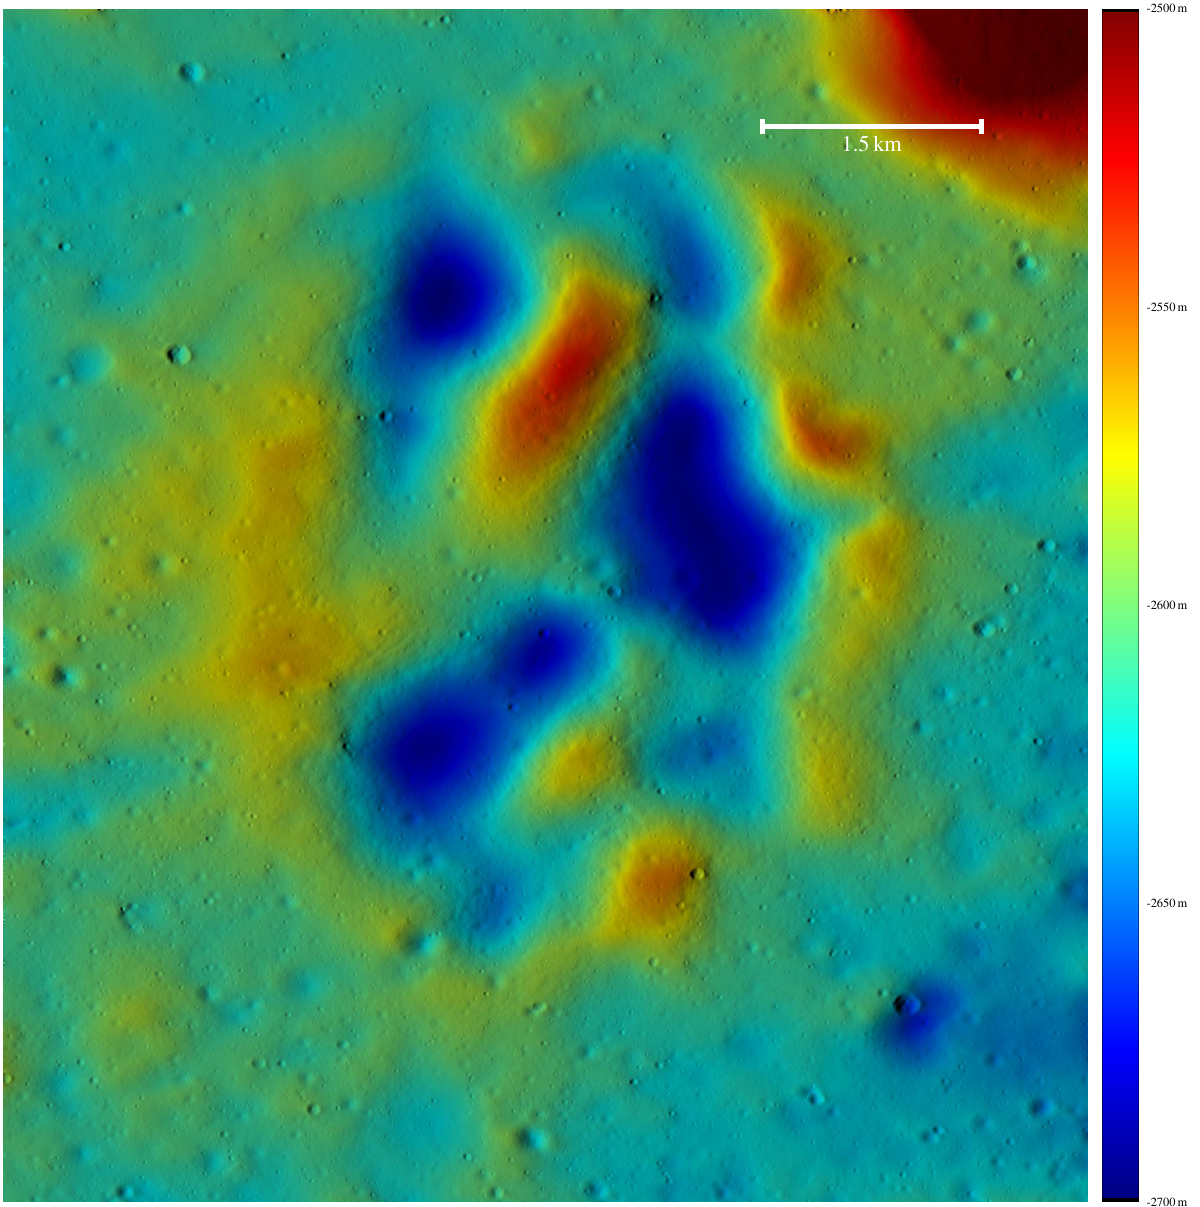
Figure 5: Close-up view of Area